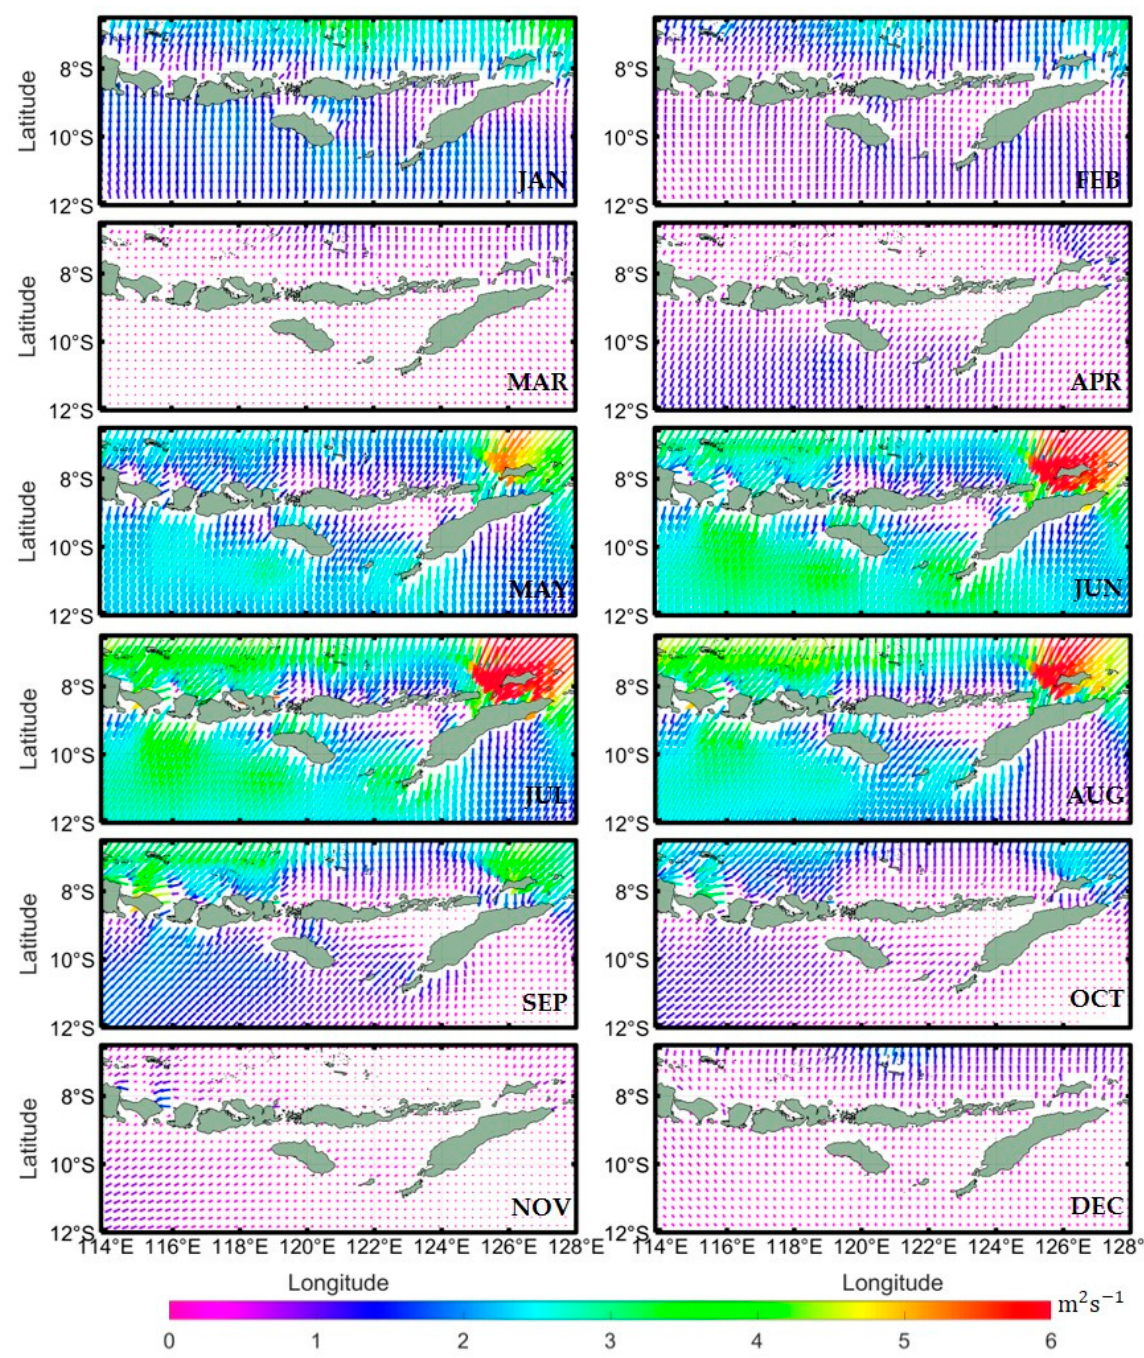
Figure 8. The climatological monthly mean values of Ekman Mass Transport (EMT) during 2007–2020.